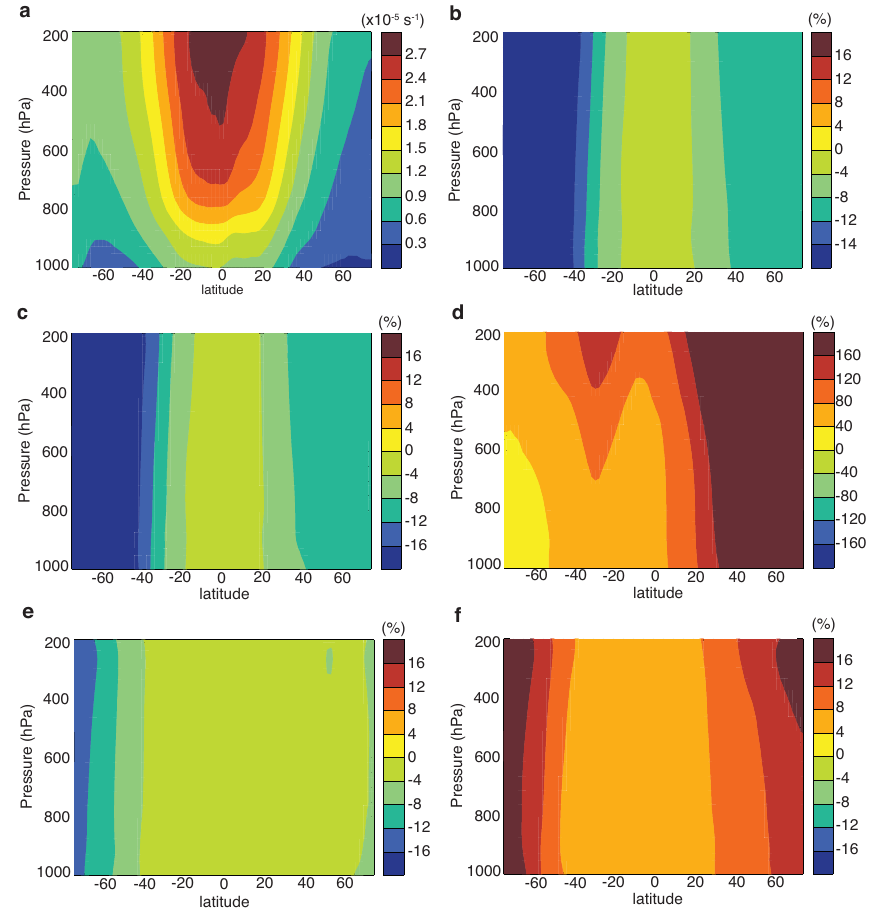
Fig. 1. Photolysis rate changes in the sensitivity experiments. Annual zonal mean J(O 1 D) in the BASE simulation (a) , and difference of annual zonal mean J(O 1 D) in the 1960CFCs (b) , the 2100CFCs (c) , the WACFCs (d) , the 1850N2O (e) and the 2100N2O (f) simulations, from the BASE run. Note the difference in the colour scale in (d)